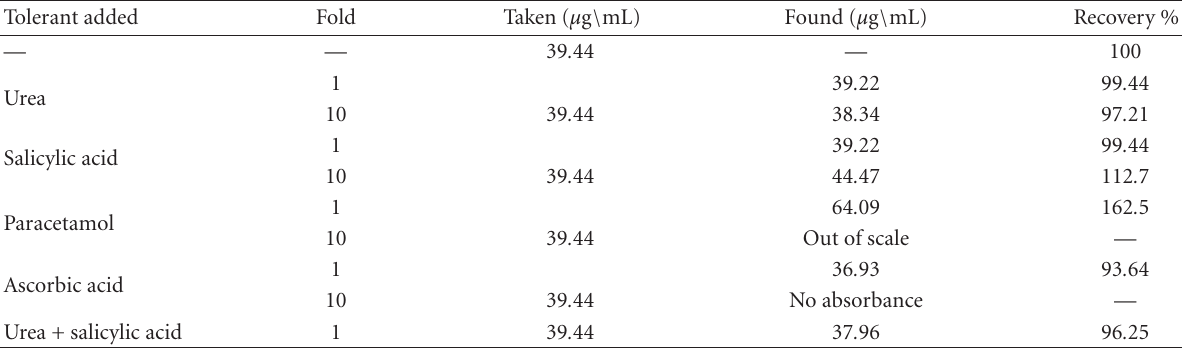
Table 3. E ff ect of common tolerances that may be present in the urine sample with LD using copper tetramine complex and 4-AAP.